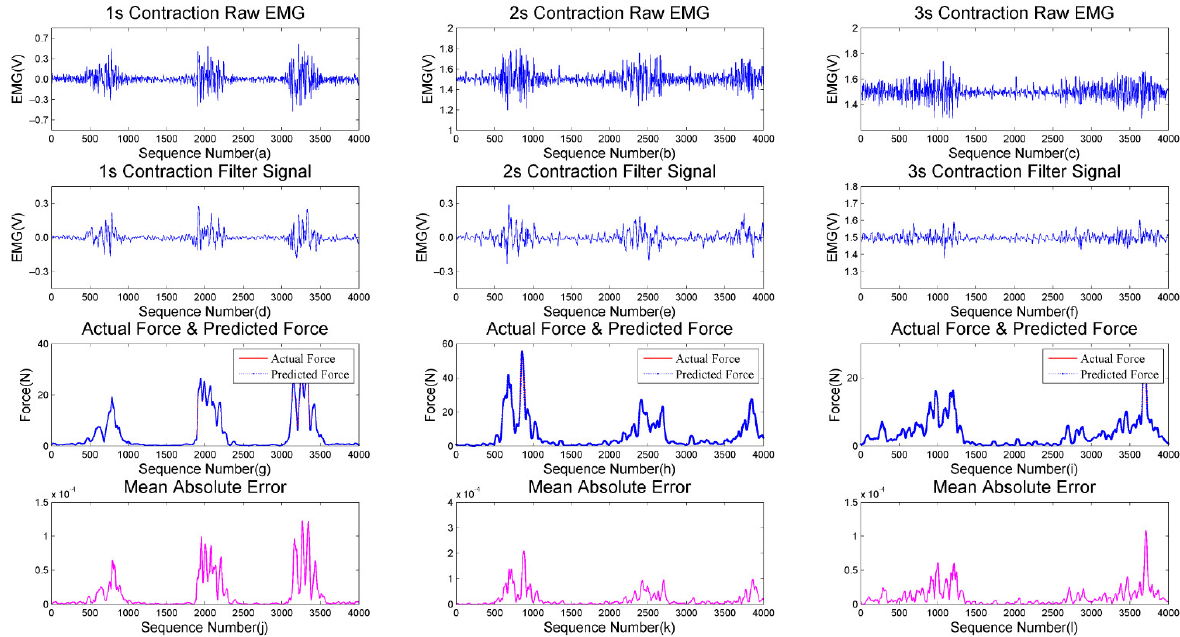
Figure 11. Box diagram of evaluation of window size in the algorithm: ( a ) NRMSE; ( b ) Coefficient of Determination.